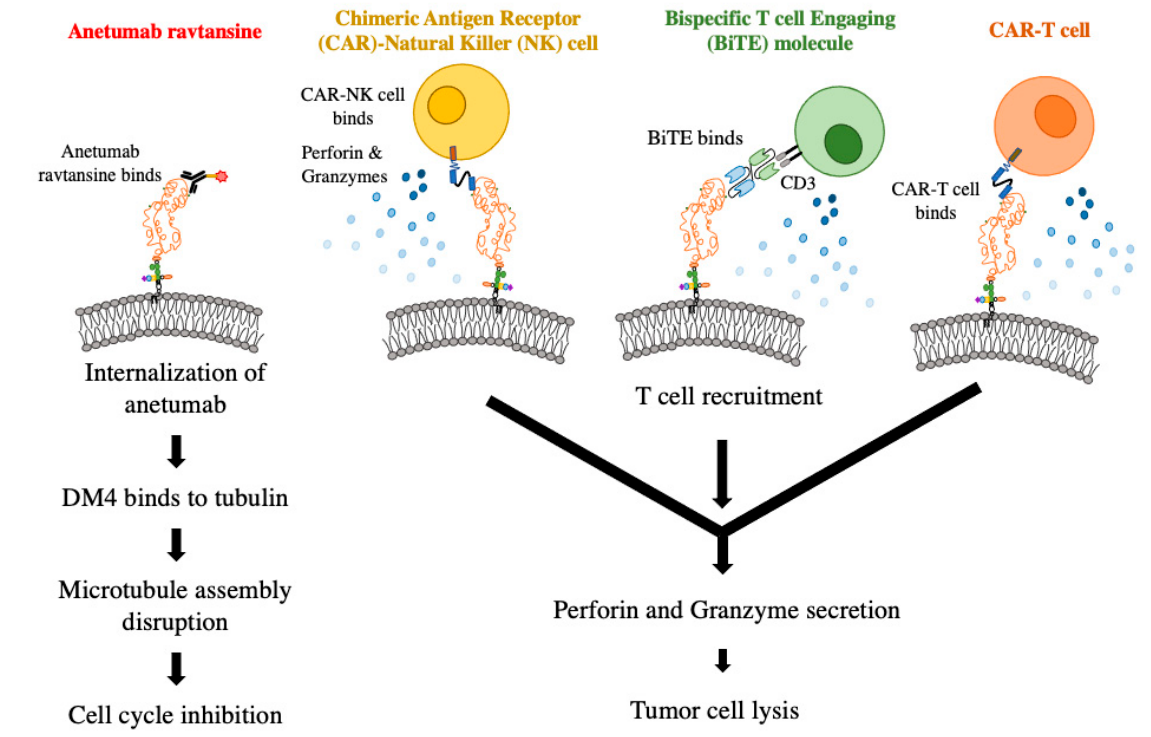
Figure 3. Mesothelin-targeted therapies in preclinical development for pediatric AML. Anetumab ravtansine is an antibody–drug conjugate (ADC) that is an scFv for mesothelin attached to DM4 (red star), a tubulin inhibitor, via a linker (yellow). Once bound to mesothelin, DM4 is internalized and binds to tubulin, which disrupts microtubule assembly and cell cycle is inhibited, which results in cell death. Chimeric antigen receptor (CAR) therapy uses a variety of host immune cells to elicit a tumor-targeted response using a construct designed to recognize a target antigen. In AML, CAR-NK cells (yellow), and CAR T cells (orange) have been investigated. Upon the recognition of the target antigen, NK and T cells activate and elicit a killing mechanism through the secretion of perforin and granzymes (blue), resulting in tumor cell lysis. Bispecific T cell-engaging molecules (BiTEs) work mechanistically by recruiting T cells to tumor cells by engaging with a tumor-associated antigen (shown in blue), while the other side of the molecule engages with a CD3 on a T cell (shown in green). Once bound, the T cell becomes activated and kills through the same mechanisms at the CAR cell